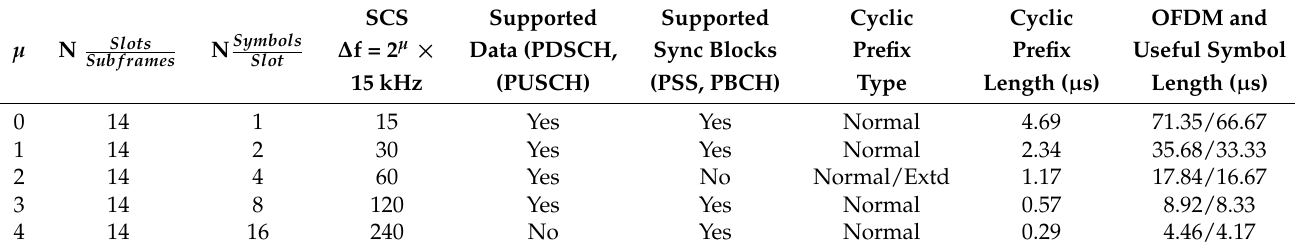
Table 6. 5G numerology.